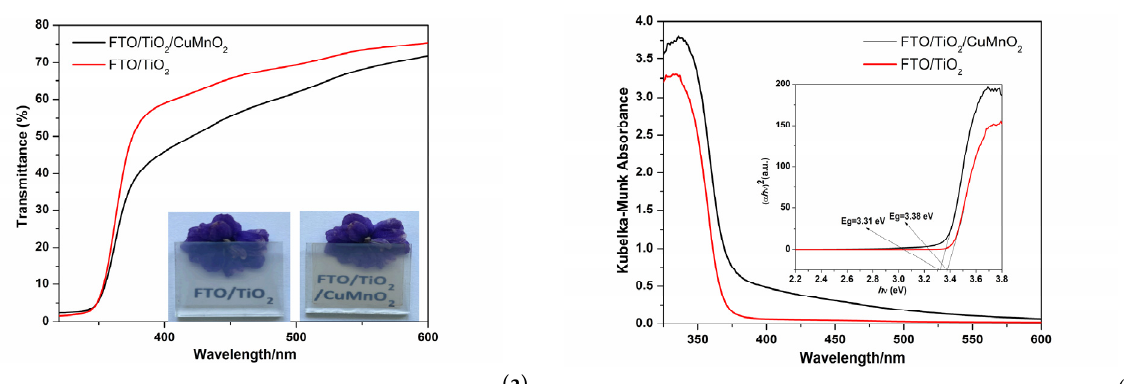
Figure 5. Transmittance spectra and pictures of FTO-TiO 2 and FTO-TiO 2 -CuMnO 2 transparent films ( a ); Kubelka–Munk absorption and Tauc’s plot for Eg calculation ( b